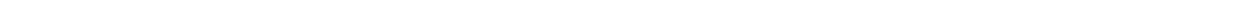
Fig. 4 Classi fi cation and characterization of TAD boundaries according to insulation score (high sequencing depth = 80 million intrachromosomal read pairs). a Work fl ow of strati fi cation of TAD boundaries by insulating score. b Heatmap representation of TAD boundary insulation strength across samples; hierarchical clustering correctly groups replicates and related cell types independent of enzyme biases or batch effects related to the lab that generated the Hi-C libraries (detailed information about all Hi-C data sets and their cell types is included in Supplementary Data 1). c TAD boundary strength is associated with CTCF levels. d Comparison of the association of “ ratio ” vs. “ crane ” insulation scores with CTCF levels. e Fraction of super-enhancer elements in the vicinity of boundaries of variable strength. f Comparison of the association of “ ratio ” vs. “ crane ” insulation scores with respect to proximity to super-enhancers. All statistical tests are paired two-sided Wilcoxon rank-sum tests between distributions de fi ned across samples (each sample is a dot in the boxplots). The box in each boxplot represents the fi rst (Q1) and third (Q3) quartiles and the ends of the whiskers are positioned 1.5*(Q3-Q1) away from the ends of the